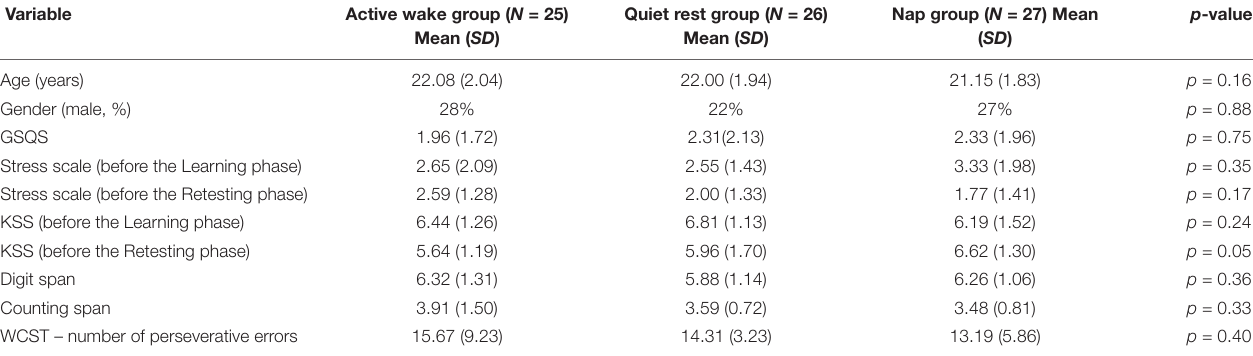
TABLE 1 | Descriptive characteristics of